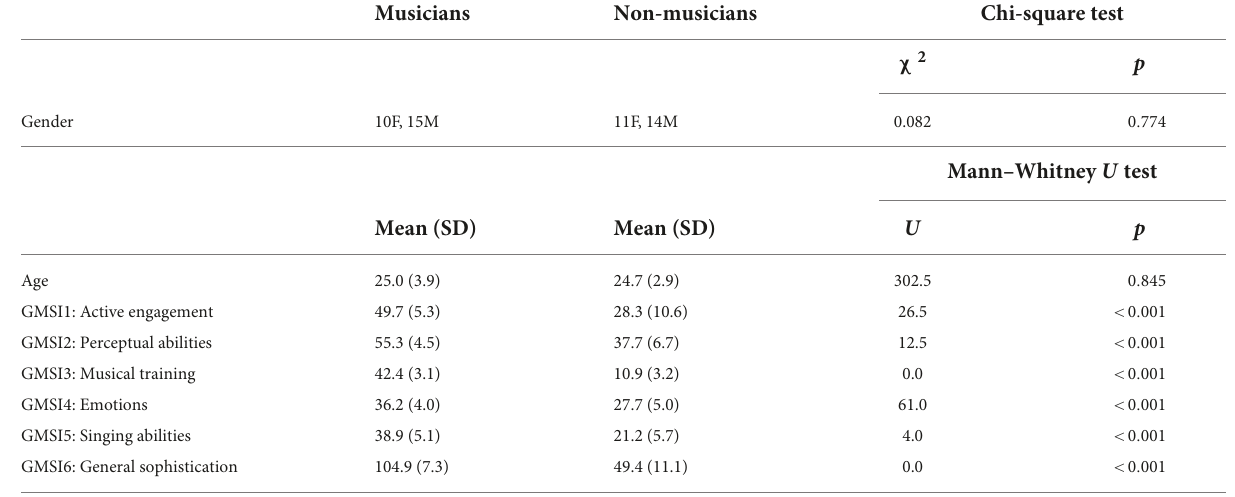
TABLE 1 Demographics and musical sophistication of research